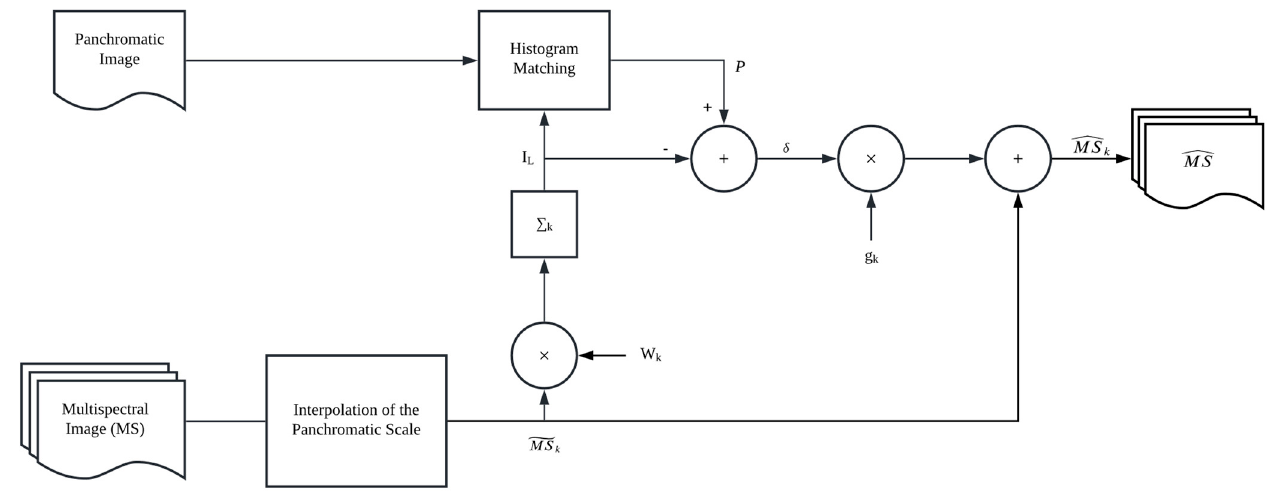
Figure 5. Flowchart of the component substitution method representing a generic pan-sharpening procedure. Adapted from [69]. In this sketch, δ = (P − I L ) . This flowchart is a graphical representation of the procedures expressed in Table 4 and Equations (4) and (5).